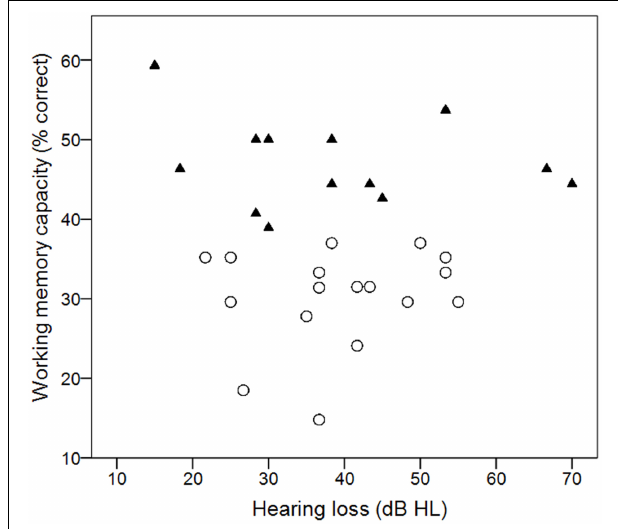
FIGURE 2 | Individual working memory scores as a function of hearing loss. Filled triangles and open circles show individual scores that fall above or below the median